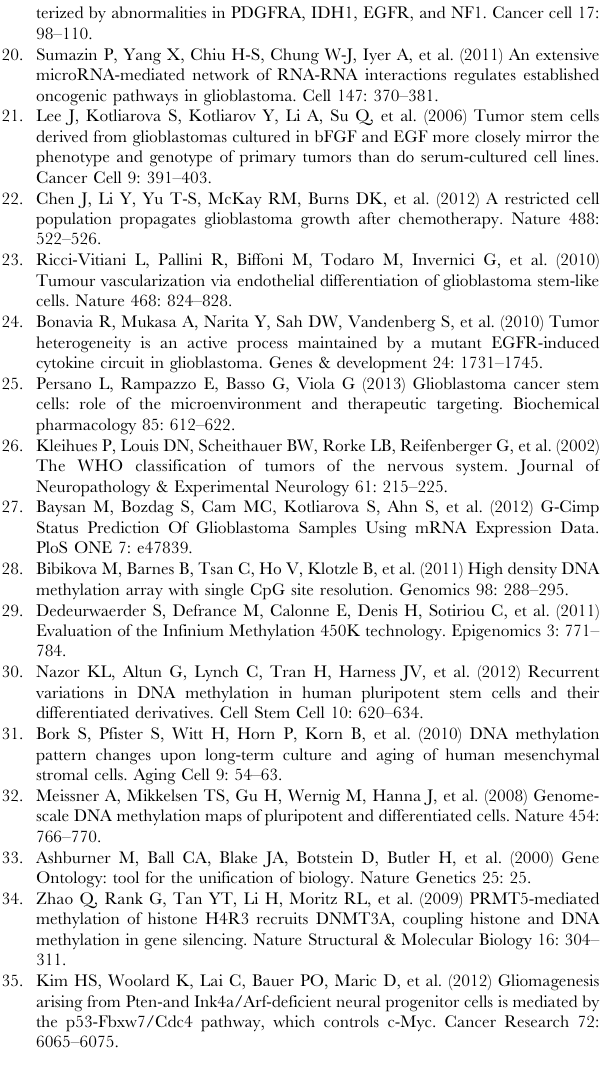
are used. Differentially methylated sites determined with paired non-parametric Quade test and sites with false discovery rate less than 0.05 (Benjamini-Hochberg) and absolute methylation difference greater than 0.3 are colored red and blue others are colored gray. Figure S6 In vitro differentially methylated and differ- entially expressed 238 genes with fold changes are uploaded Ingenuity Pathway Analyses software for functional enrichment. These are the enriched most catego- ries; blue sub-categories are inhibited and orange ones are activated in vitro.